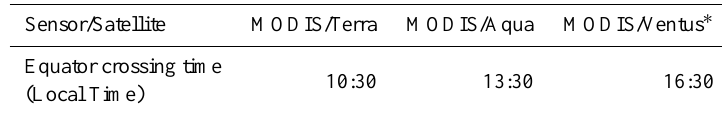
Fig. 4. Vertical distributions of annual and zonal averaged aerosol extinction coefficients. (a) total aerosol extinction coefficient by ONS and deviations (OFS minus ONS) of aerosol extinction coefficient for (b) total, (c) sulfate, (d) carbon, (e) sea-salt, and (f) dust aerosols. Table 4. List of satellites in sun-synchronous polar orbits considered in the inversion